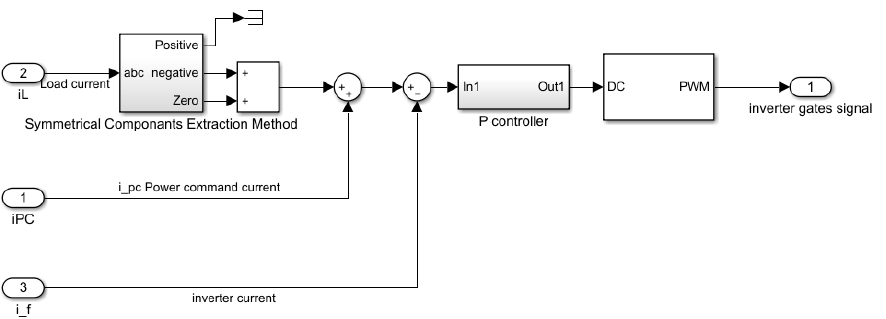
Figure 3. Current control block diagram of the proposed